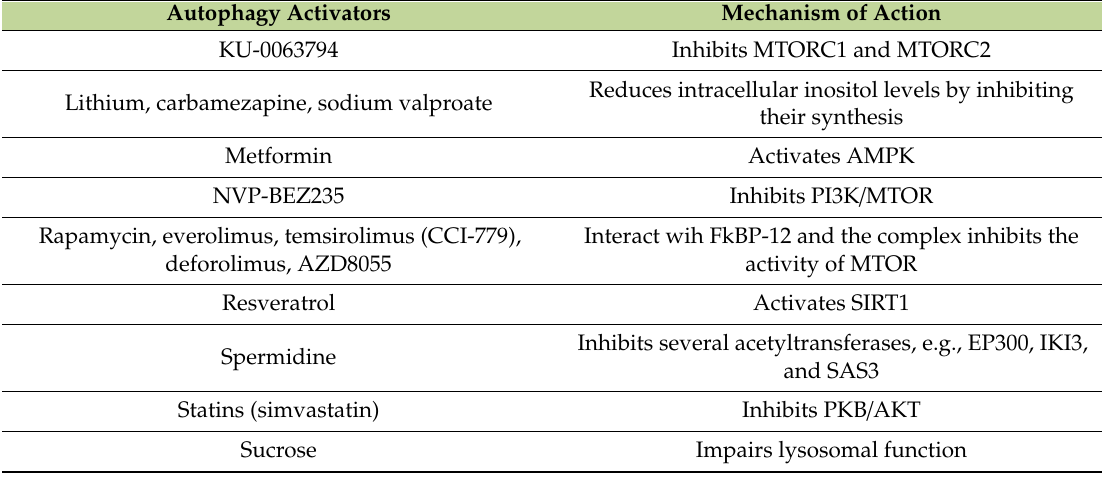
Table 1. Examples of autophagic and lysosomal activators and inhibitors (non-exhaustive list) 1